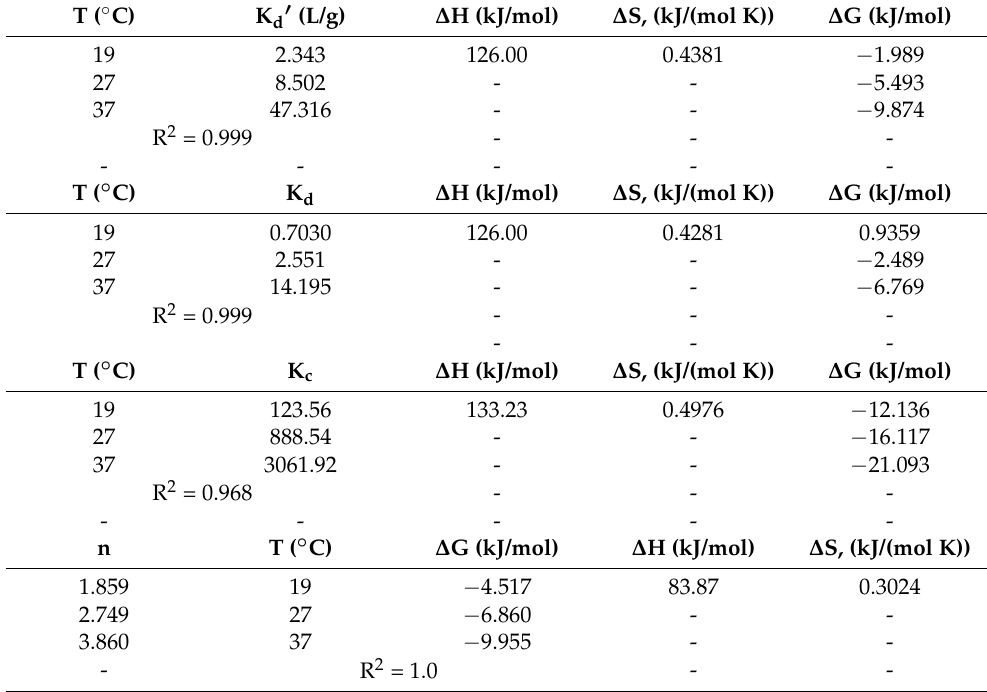
Table 3. Thermodynamic